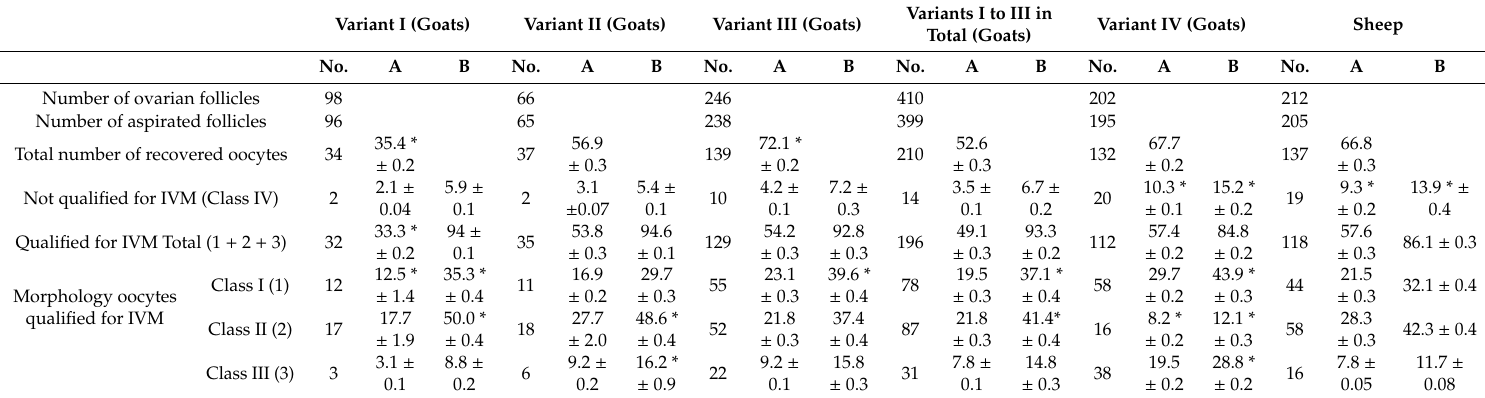
Table 1. The e ff ectiveness of the laparoscopic ovum pick-up (OPU) method among goats and